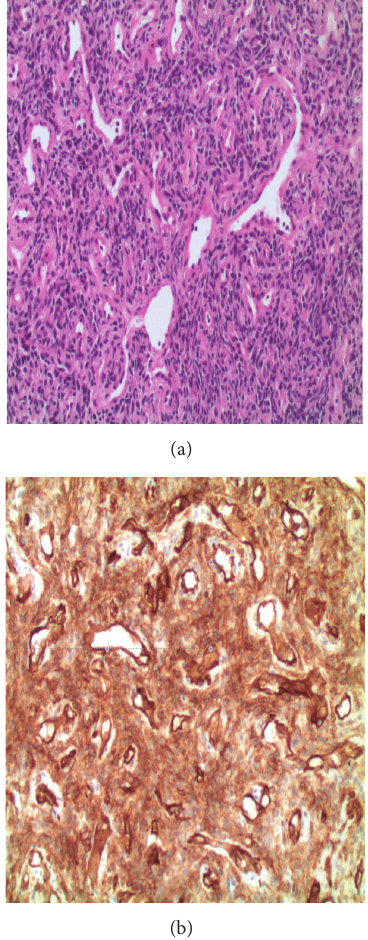
Figure 1: (a) Microscopic description: the tumor is cellular and composed of many variable ectatic and compressed thin walled branching vessels, giving staghorn configuration. The surrounding tumor cells are spindled to round with scant pale to eosinophilic cytoplasm, bland vesicular nuclei, and low mitotic activity. (b) Immunohistochemically, the tumor cells stain positive for CD34. The combined morphology and immunoprofile are consistent with